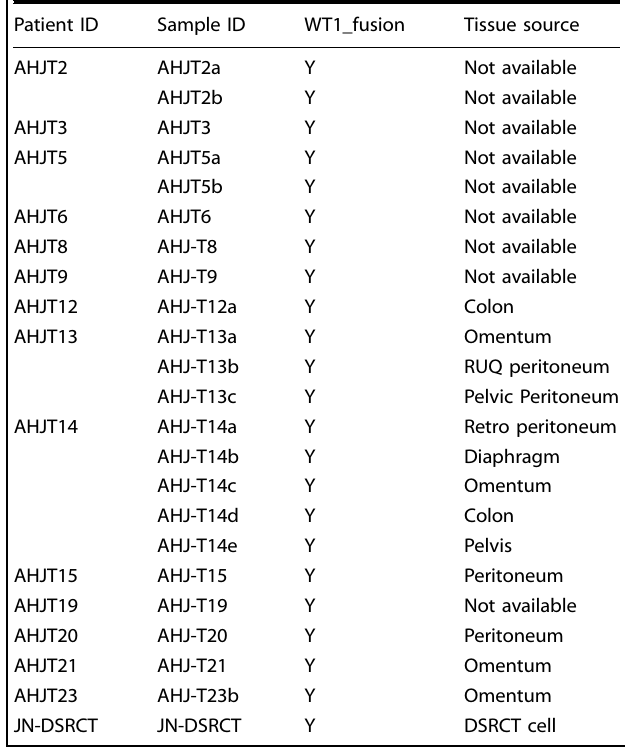
Table 2. Information of samples from 14 patient and 1 cell